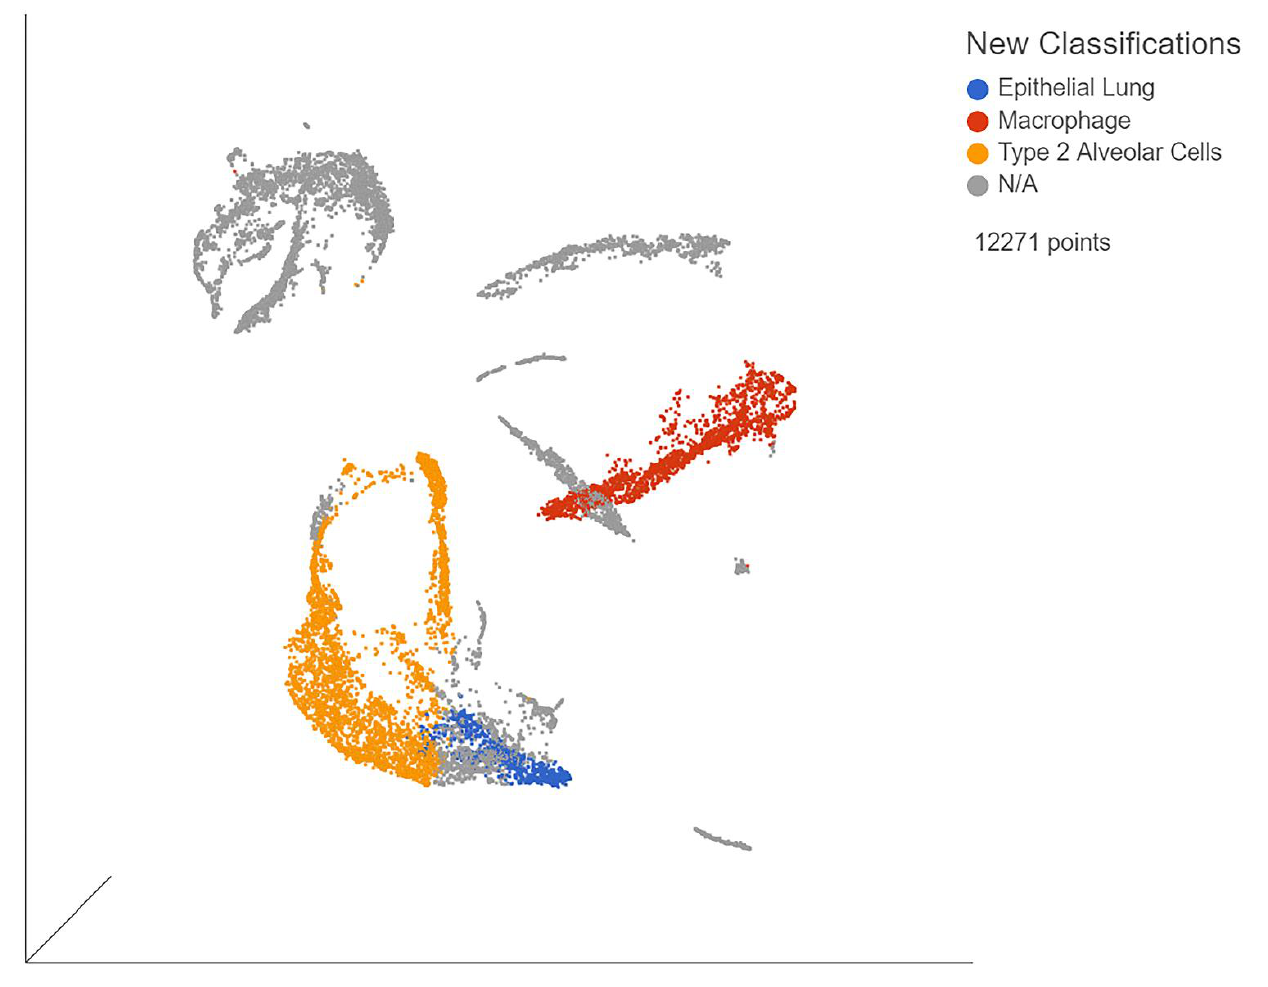
Figure 2. UMAP of blue points represent general lung epithelia, red points are AT2 cells, and yellow points are macrophages. Gray points represent unclassified cells. Generated in Partek Flow.